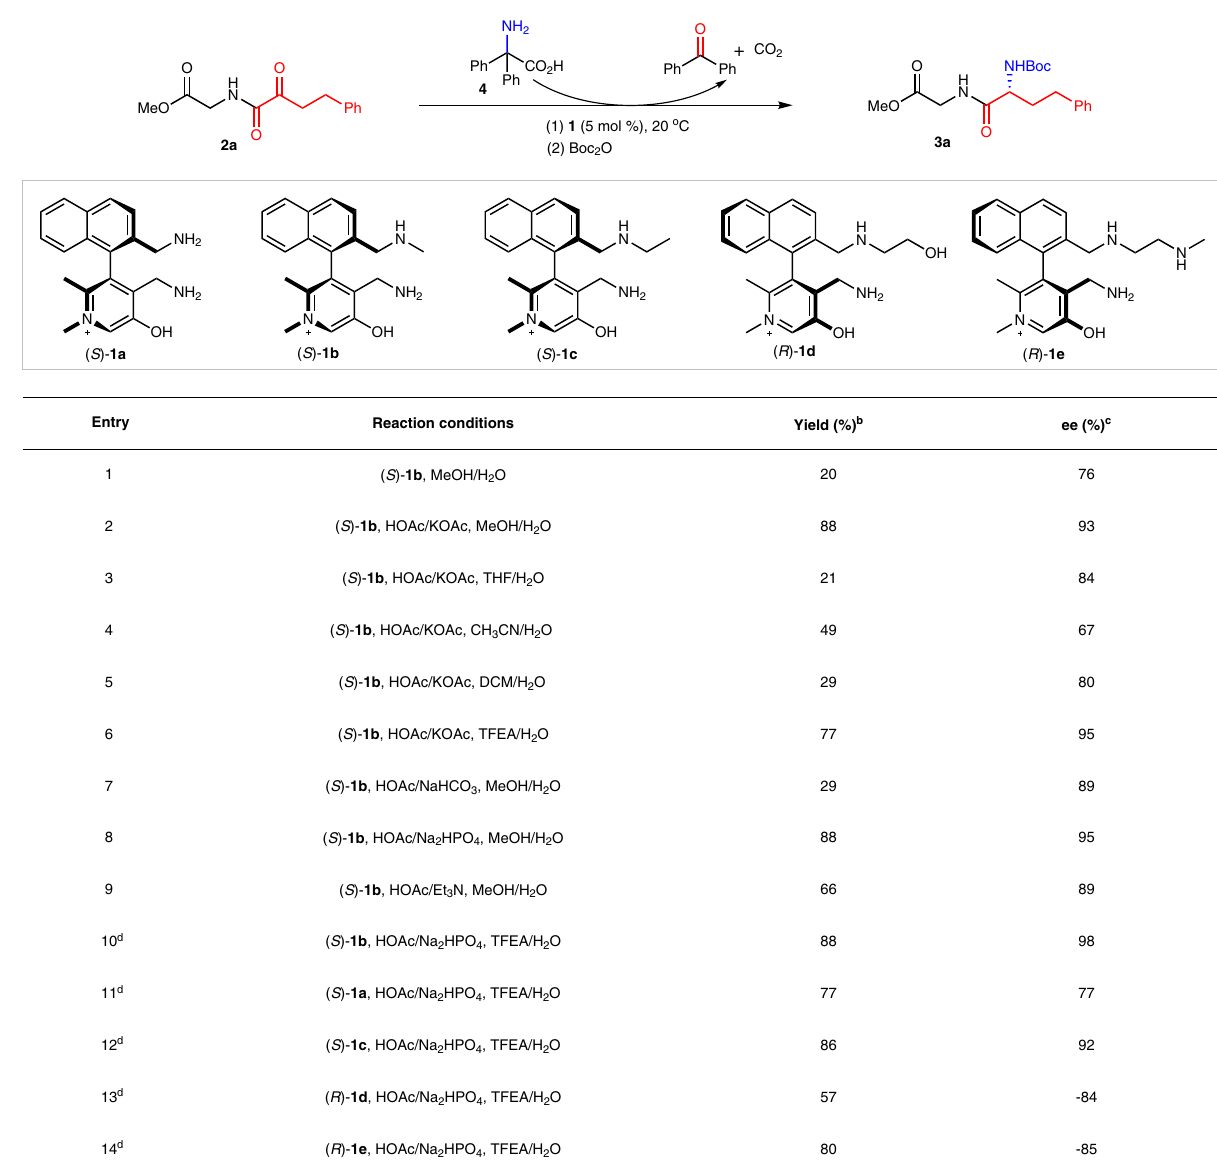
Fig. 3 Investigation of reaction parameters. TFEA = 2,2,2-tri fl uoroethanol. a Reaction conditions: 2a (0.10mmol), 4 (0.11 mmol), 1 (0.0050 mmol), HOAc (0.40 mmol), base (0.20 mmol) in solvent (0.48 mL) and H 2 O (0.12 mL) at 20 °C for 48 h unless otherwise stated. The reaction mixtures were then treated with di- tert -butyl dicarbonate (0.30 mmol) at rt for 3 h. b Isolated yields based on α -keto amide 2a . c The ee values were determined by HPLC analysis. d Reaction time was 72